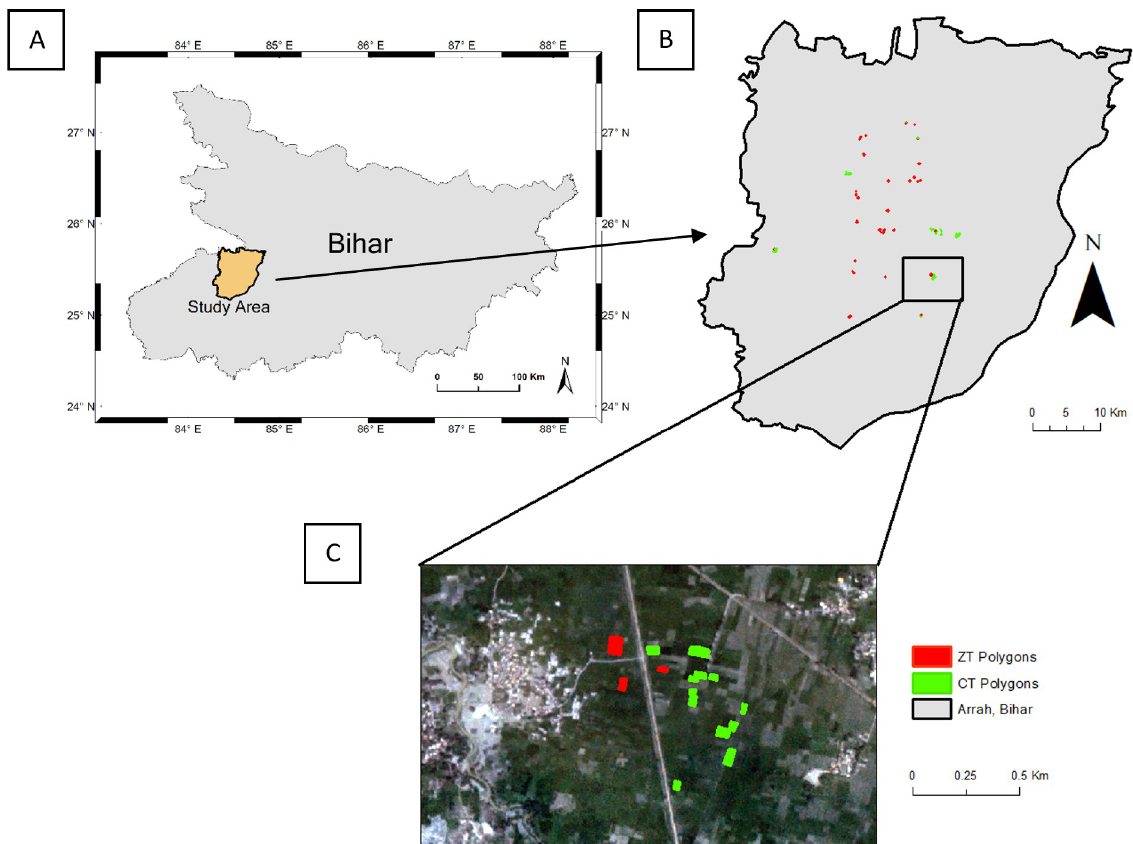
Fig 1. Schematic diagram of the study area. Maps showing (A) the location of our study area in Bihar, (B) our study polygons plotted in Arrah district, Bihar and (C) a zoom in of some of our polygons overlaid on Planet